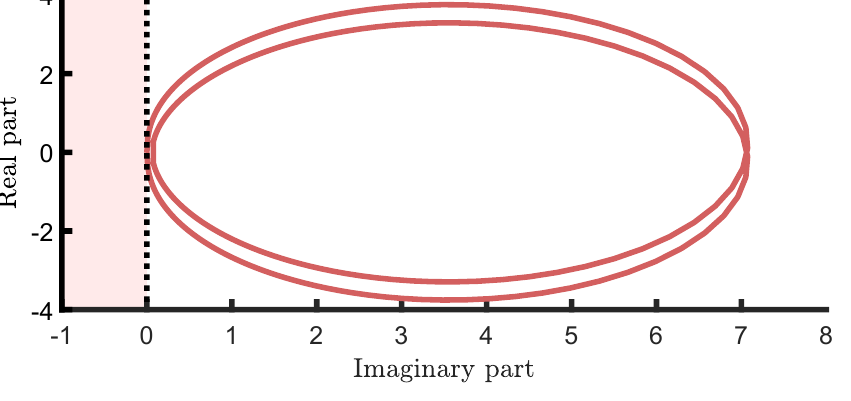
Figure 9. Nyquist plot of system